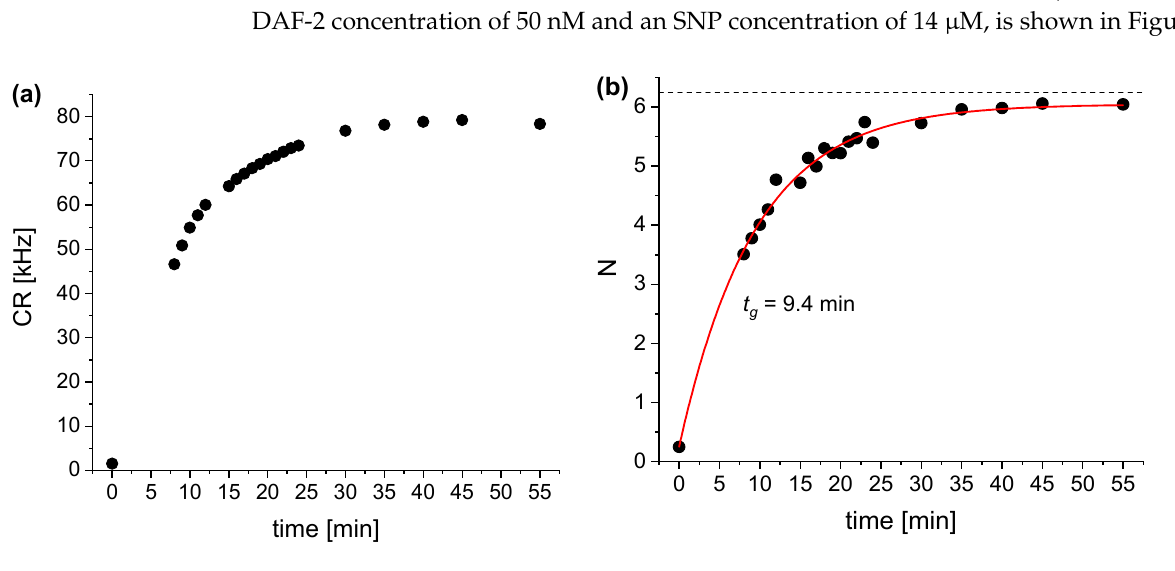
Figure 2. Plot of the time dependence of CR ( a ) and N ( b ) for the DAF-2 (50 nM) + SNP/GSH (14 µ M) solution in PBS. The dashed line ( b ) represents the expected limit corresponding to c m = 50 nM. The solid line in ( b ) shows the inversed exponential decay fit with a characteristic time of 9.4 min. As shown in Figure 2a, the fluorescence intensity (CR) increased from the back- ground value (DAF-2 in PBS) of 1.5 cts/s to 79 kcts/s within about 40 min. The initial part